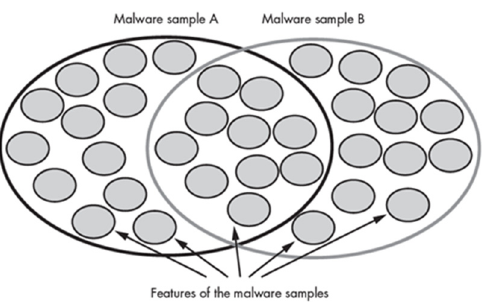
Figure 5. Shared features between two malware samples. Adapted with permission from Ref. [31].